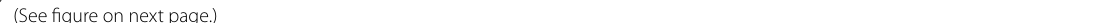
figure on next Fig. 2 Spatial TILs phenotype and sTILs scores association with NACT response. A Spatial TILs phenotype and its association with response to NACT. Table showing the number of patients according to their TILs spatial phenotype and pathological response, where the response is measured as pCR and RD. Distribution of the number of patients across four phenotypes of spatial TILs was analyzed with the 4*2 χ2 contingency test using GraphPad Prism v.5. The bold font indicates significant p -values. B‑E Spatial TILs phenotypes and its association with response to NACT across subtypes. Stacked bar graph representing percent number of patients with each spatial TILs phenotype with respect to NACT response. The therapy response is reported as pCR and RD according to the spatial TILs phenotype of the tumor for B. the IDC cohort, C. ER E. TNBC subtype. The number of patients and percentage is shown in each bar as n (%). F Table showing the distribution of IDC and TNBC patients with pCR or RD with respect to binned sTILs score; Low sTILs (< 10%), Moderate sTILs (10–40%) and High sTILs ( using GraphPad Prism V.5. G-J; Box plots depicting mean sTILs scores separated according to the response to NACT for the cohort and the three subtypes. The number of tissue samples (n) is shown on top of each bar. Error bars represent 10th and 90th percentile values. Mann Whitney test was performed to analyze significant distribution of mean sTILs scores. p -value < 0.05 is represented with ‘*’, < 0.01 with ‘**’ and, < 0.0001 with ‘***’. ns non-significant. GraphPad Prism v.5 was used for the graphs and statistical =